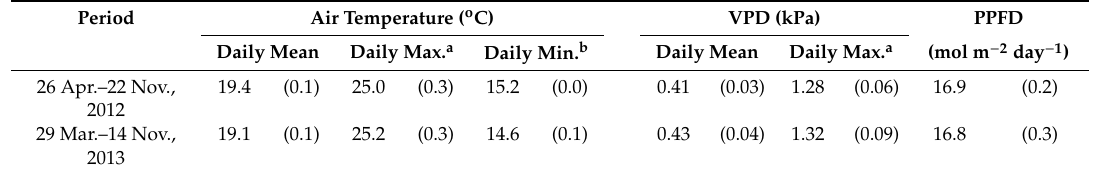
Table 1. Seasonal means of air temperature, vapor pressure deficit (VPD), and photosynthetic photon flux density (PPFD) inside open-top chambers (OTCs) during the O 3 -exposure period in 2012 and 2013. Period Air Temperature ( o C) VPD (kPa) PPFD Daily Mean Daily Max. a Daily Min. b Daily Mean Daily Max. a (mol m − 2 day − 1 )